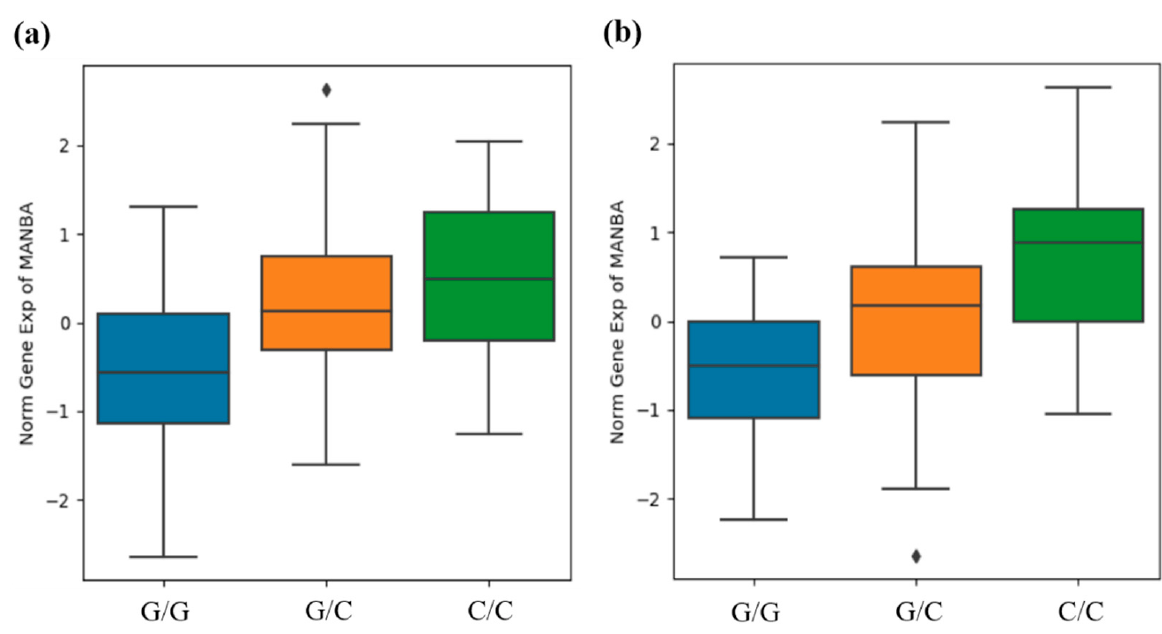
Figure 1. Rs4496586 genotype and MANBA gene expression association in human kidney tubules ( a ) and glomeruli ( b ). The data are from the Human Kidney eQTL database (http://susztaklab.com/eqtl (accessed on 13 April 2021)). MANBA gene expression for the rs4496586 genotype in tubules ( β = 0.636, p = 1.44 × 10 − 6 ) and glomeruli ( β = 0.609, p = 2.49 × 10 − 6 ) was confirmed and statistically significant. p -value was calculated by linear regression. Center lines show medians, box limits indicate 25th and 75th percentiles, and whiskers extend to the 5th and 95th percentiles, outliers are represented by diamonds.